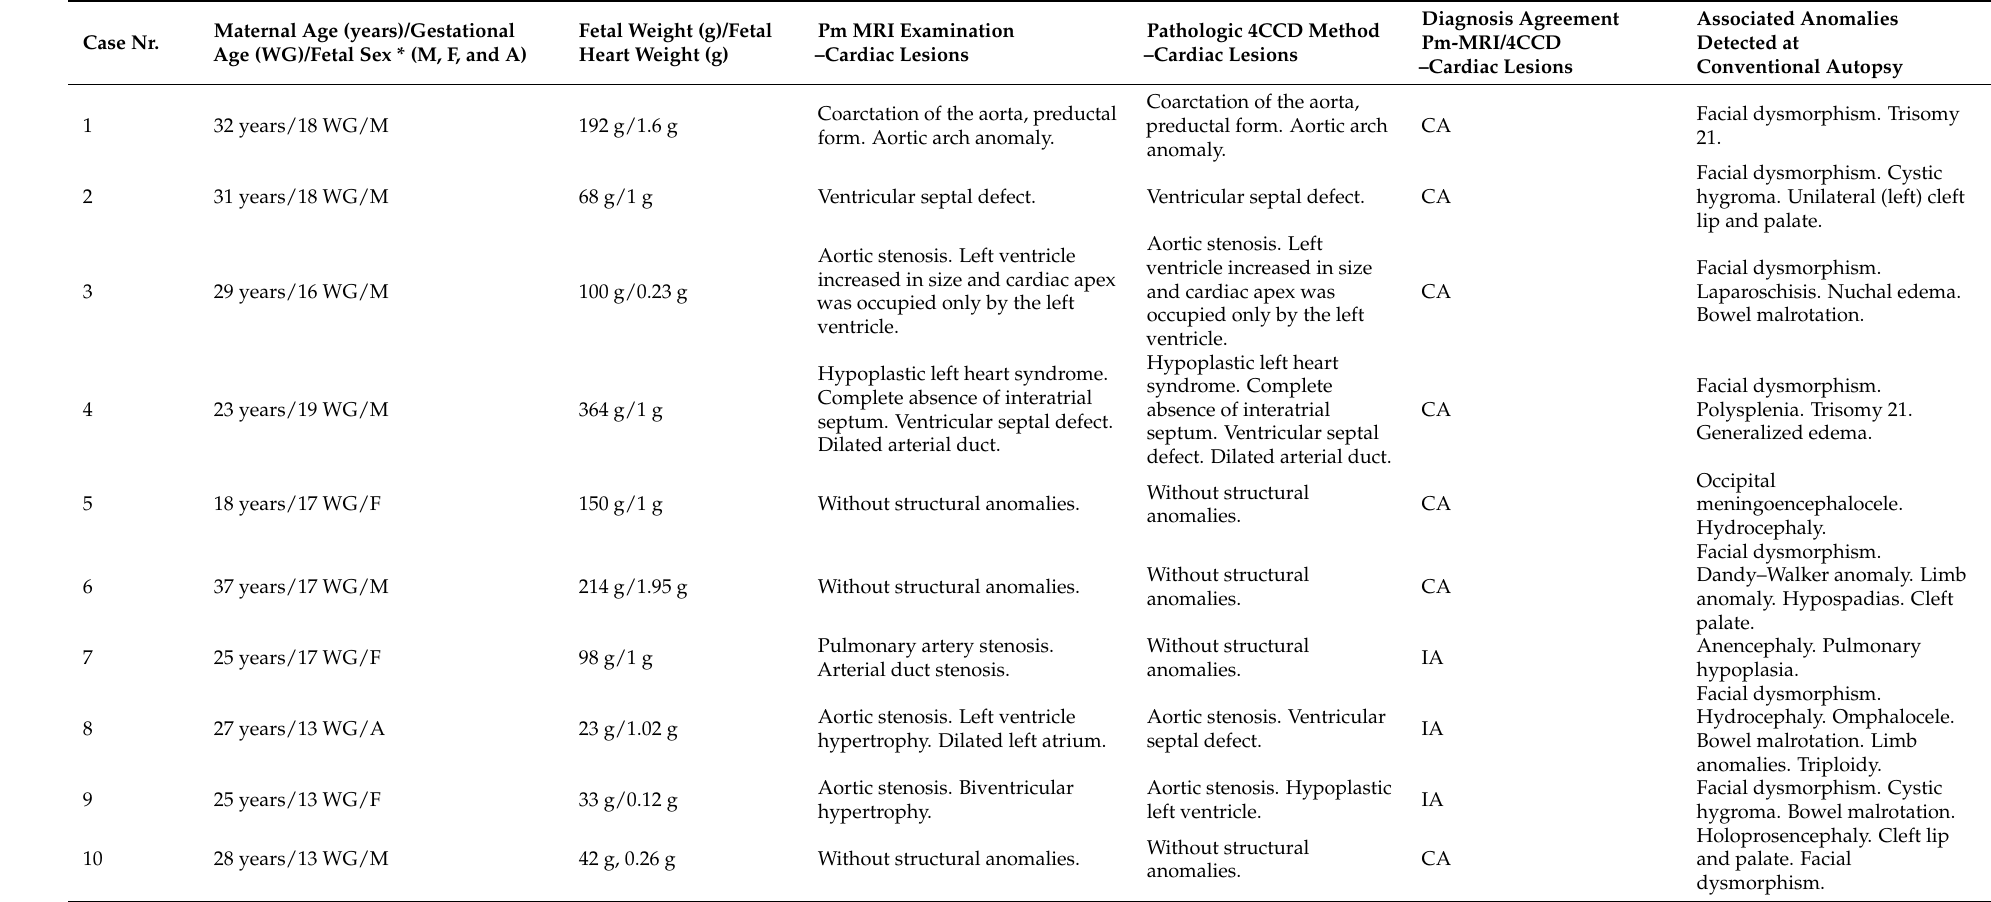
Table 1. Specific characteristics and diagnostics for all cases included in our